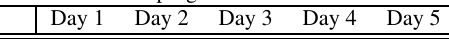
Figure 4: Floor plan of the garden house in Ostia Antica generated as an orthogonal projection of the 3D model without the protection roof. The scan positions are marked. Left: The red lines show the graph used during the global optimization of the model reconstruction. Right: The arrows indicate how the scans were registered with the feature-based registration. Green arrows with solid lines indicate the scans that were registered with the standard settings. Red dashed lines mark those pairs where a modification of the parameters was necessary. The outdoor scan pair connected with a black dotted line was not registrable at all. Table 1: Work progress in Ostia